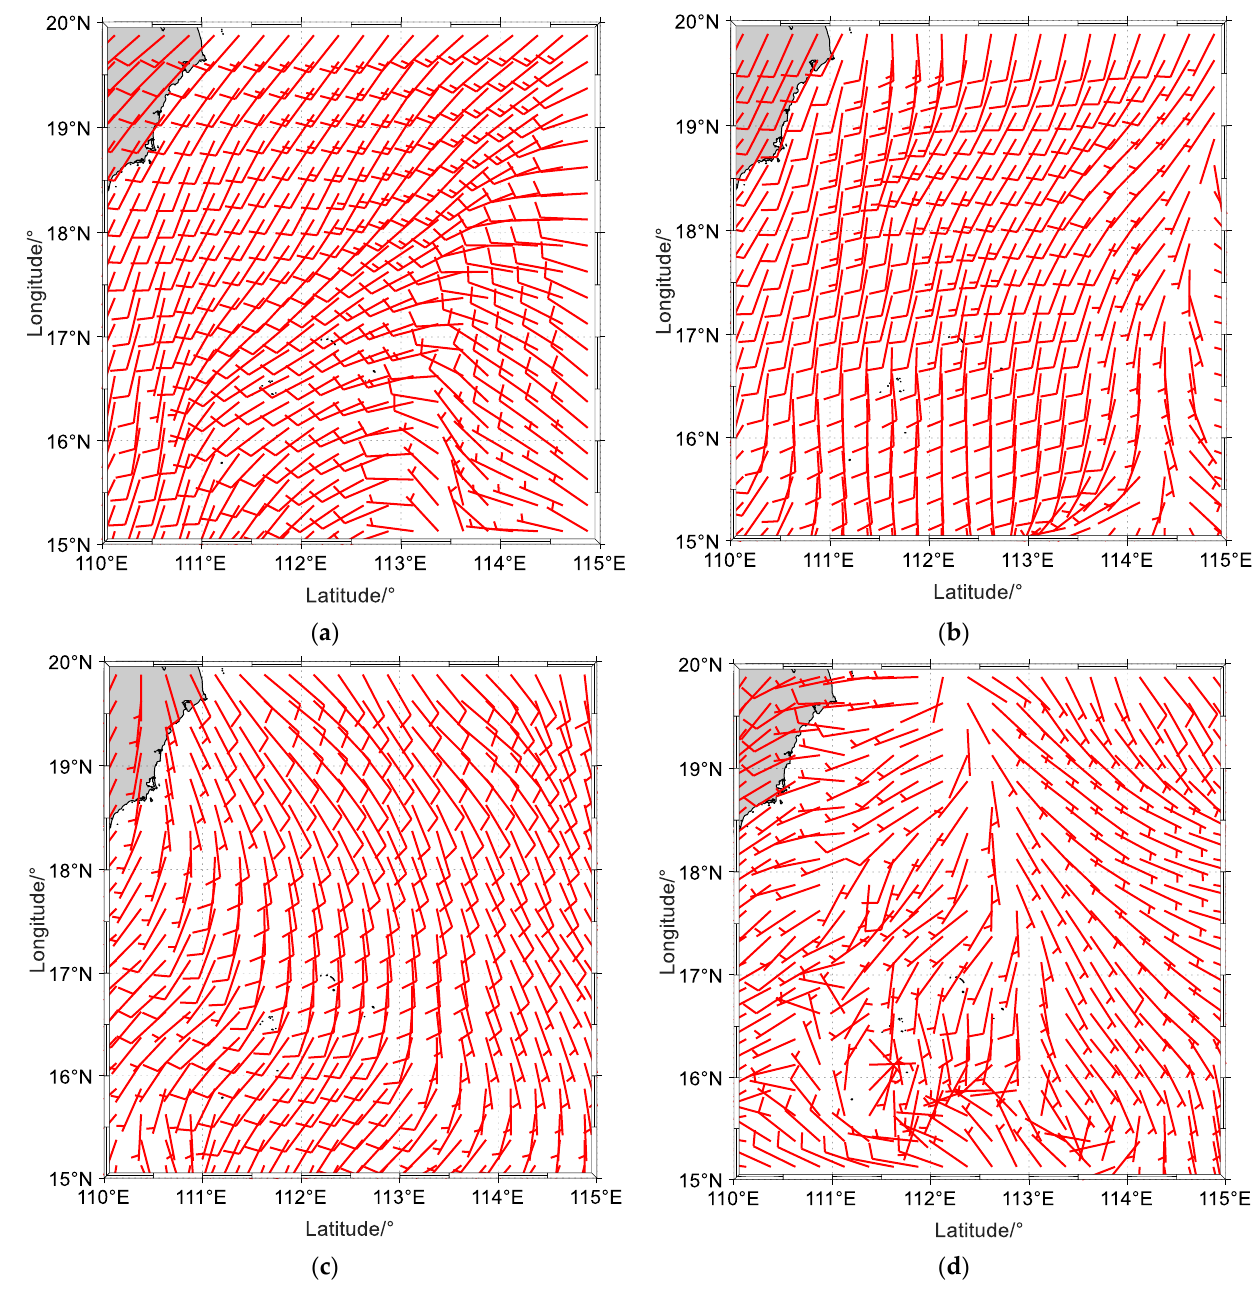
Figure 12. Real wind field at different moments. ( a ) Wind state at 00:00 on 6 June 2021, ( b ) wind state at 00:00 on 7 June 2021, ( c ) wind state at 00:00 on 8 June 2021, and ( d ) wind state at 00:00 on 9 June 2021.